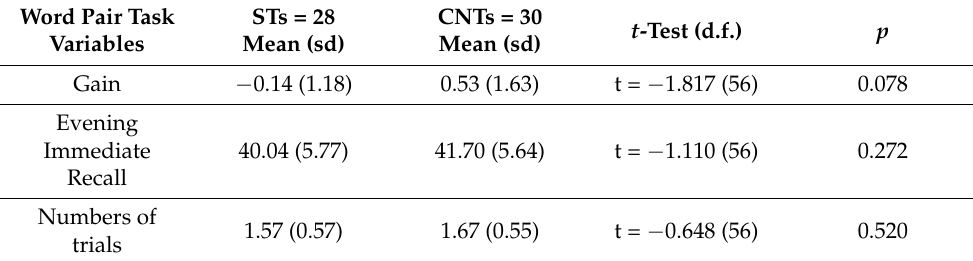
Table 4. Comparison results of WPT variables.